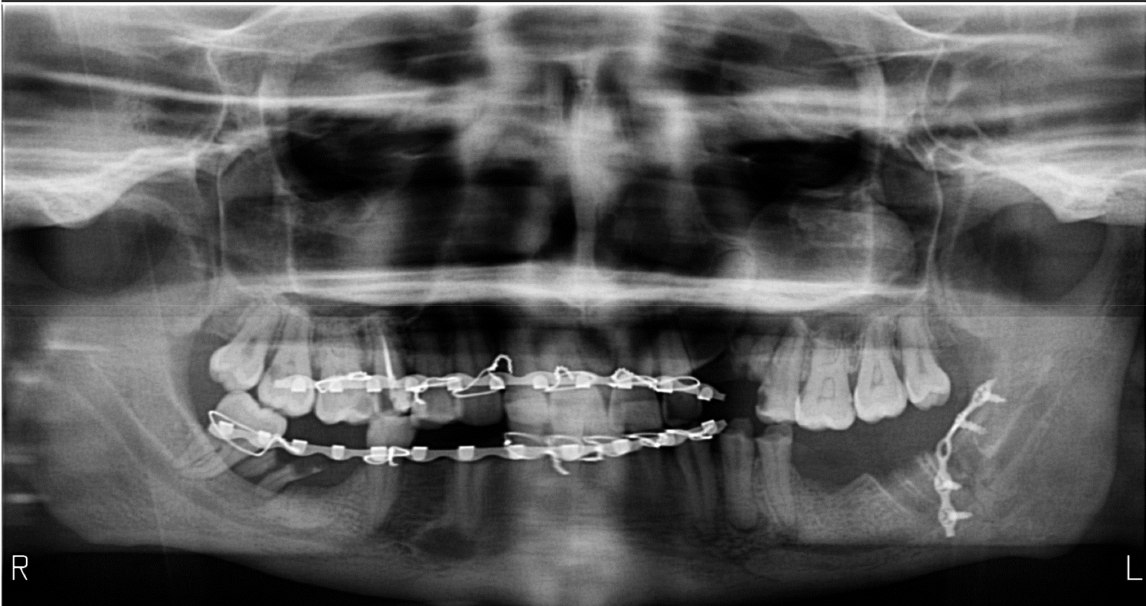
Figure 3. Orthopantomography with a sad appearance, a blurred frontal region, produced by the head extension position, in a patient treated surgically for a fracture of the left angle of the mandible. The asymmetry between the right and left sides with a larger hemi-mandible on the right side is produced by a lateral deviated position of the head towards the left side. Additionally, superior apical portions in the frontal region are obscured by an air band in the palatoglossal space. The bite-block was not used due to bimaxillary